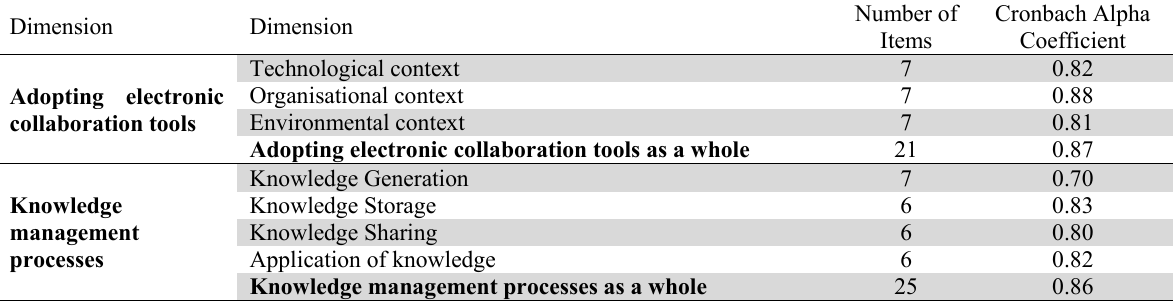
Number of Cronbach Alpha Items Coefficient